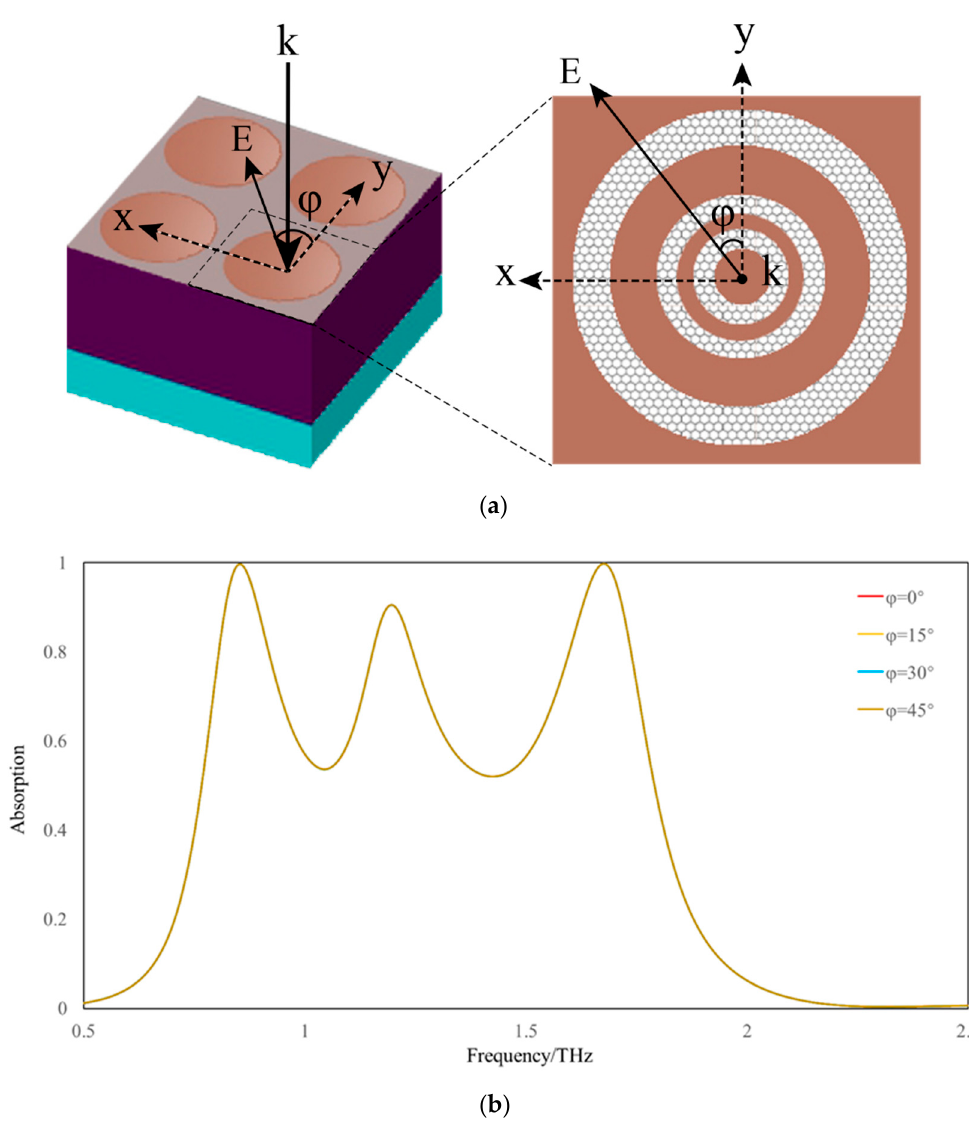
Figure 6. Schematic diagram and absorption of the polarization angle of the incident electromagnetic wave propagating to the absorbing structure. ( a ) is the scheme which describes the polarization angle φ to the proposed absorber, ( b ) is the absorption of the different polarization angle in the range of 0.5 THz to 2.5 THz. The red line indicates the absorption rate at φ = 0°, the yellow line indicates the absorption rate at φ = 15°, the blue line indicates φ = 30°, and the brown line indicates φ = 45°. We also tried to simulate the incident angle k from 0° to 30° every 10° to get a graph of the absorption data for the incident angle change (We define the angle of k as the angle between the propagation direction of the incident light and the normal to the plane of the absorption structure).